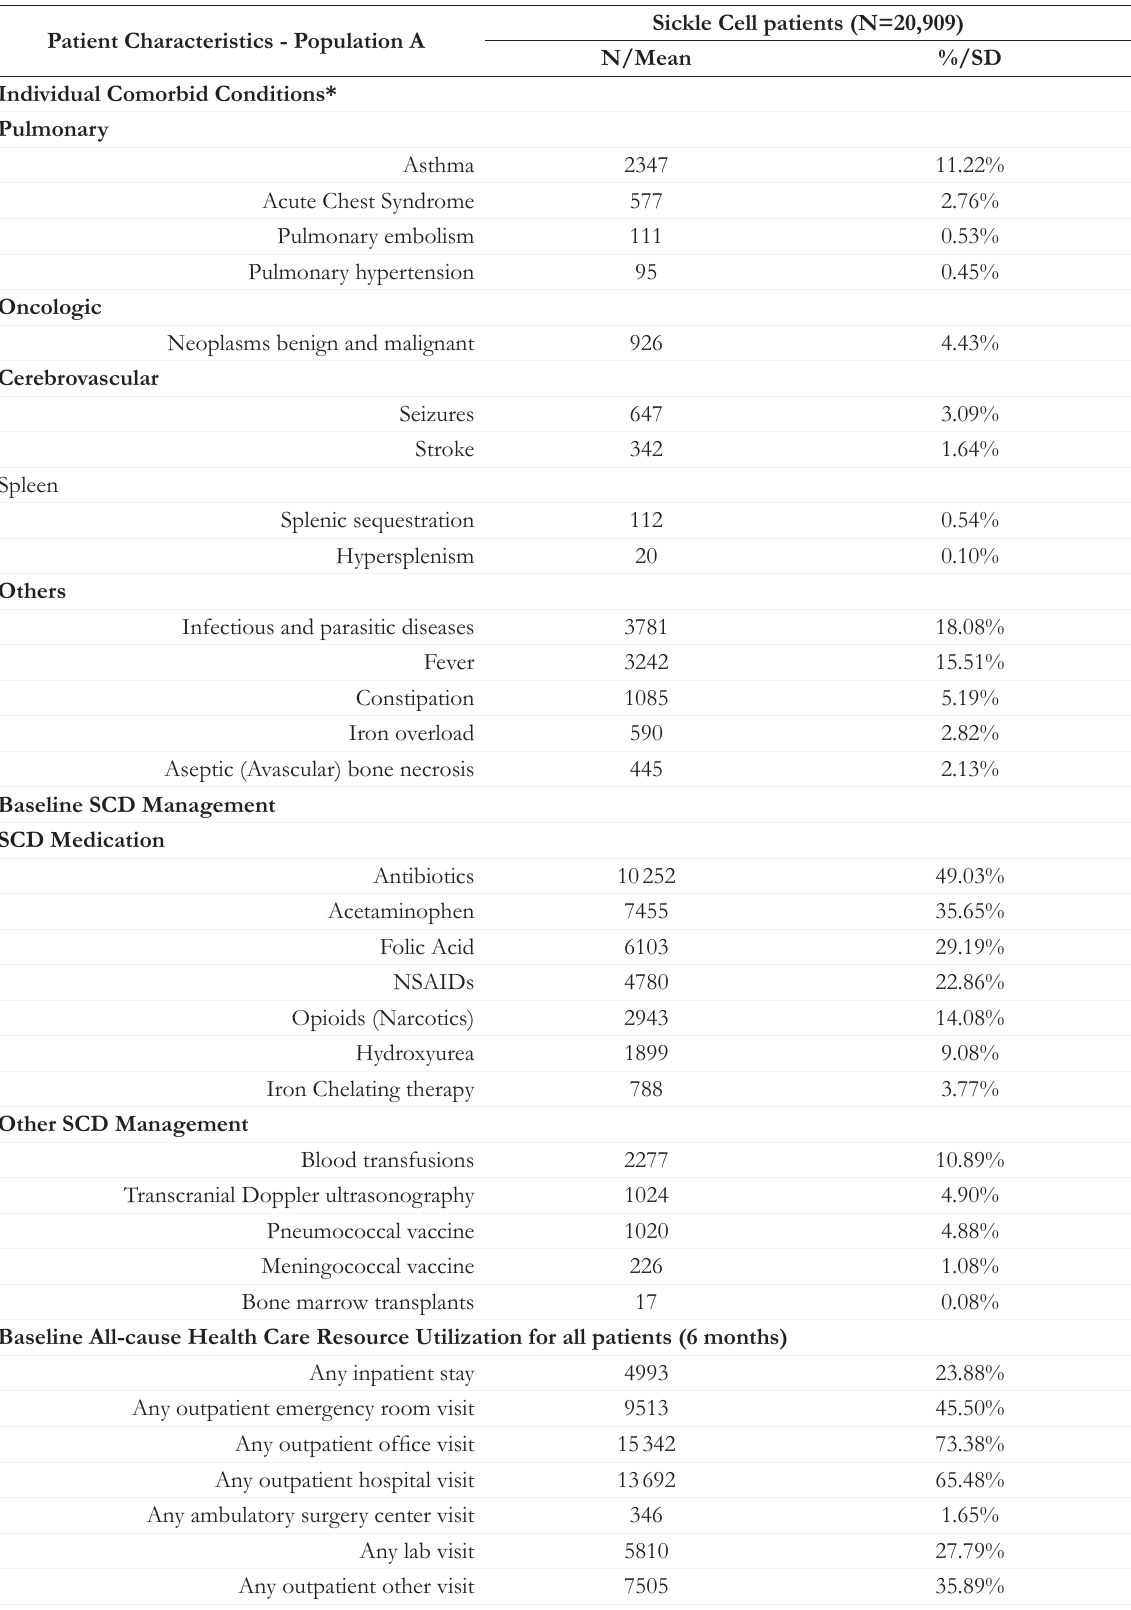
Table 1. Baseline Characteristics for Overall SCD Patients - Continued Patient Characteristics - Population